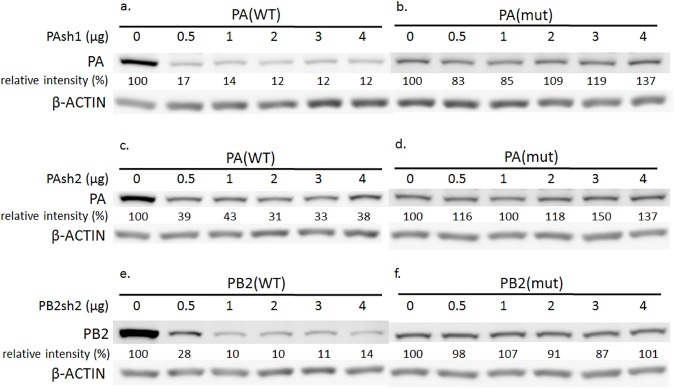
Inhibitory ability of shRNA treatment in wild type versus mutant PA and PB2 proteins.Four plasmids, two containing wild-type (WT) and two mutant (mut) viral proteins, individually co-transfected with inhibitory shRNAs. (a) PAsh1-shRNA and PA (WT) plasmids, (b) PAsh1-shRNA and PA (mut) plasmids, (c) PAsh2-shRNA and PA (WT) plasmids, (d) PAsh2-shRNA and PA (mut) plasmids, (e) PB2sh2-shRNA and PB (WT) plasmids, and (f) PB2sh2-shRNA and PB (mut) plasmids. The shRNA inhibitory effects on wild type (WT) PA and PB2 proteins were evident in Western blots, while no inhibitory effects were seen in the mutant (mut) protein expression levels. The knockdown effects of the shRNAs on wild type proteins were concordant with the administered dose.